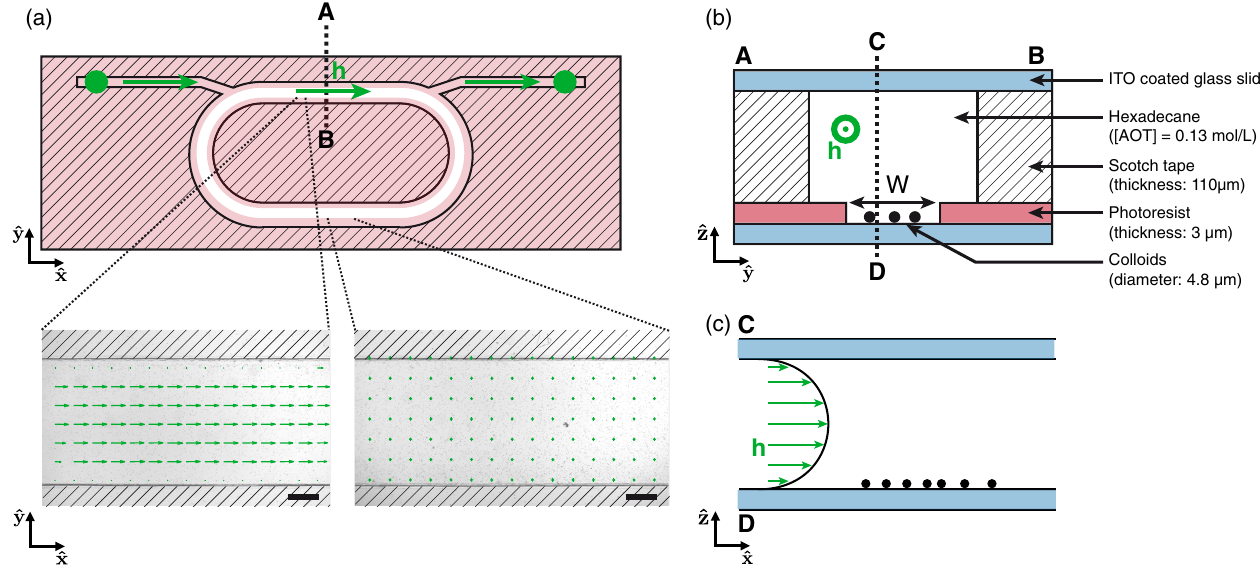
FIG. 6. Schematics of the microfluidic device. (a) Top view. The photoresist pattern is shown in red. The racetrack along which the active liquid flows corresponds to the white path. The geometry of the fluidic channel corresponds to the black solid lines. The flow direction is indicated with a green arrow. The two bottom pictures show the solvent flow field measured by particle image velocimetry seeding the hexadecane oil with colloids. Because of the imbalance between the two hydrodynamic resistances, the residual flow in the bottom branch is negligible (right picture) compared to the flow in the observation window (left picture). The scale bar represents 500 μ m. (b) Side view in the A-B section defined in (a). Two ITO coated glass slides are assembled with a double-sided tape. The colloids roll on the bottom ITO surface and are confined by the photoresist pattern (red). (c) Side view in the C-D section as defined in (b). The hexadecane flow has a Poiseuille profile along the z